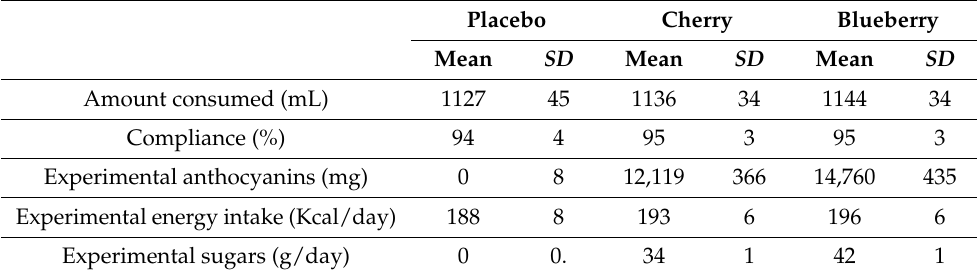
Table 2. Supplementary compliance and consumption throughout the intervention.